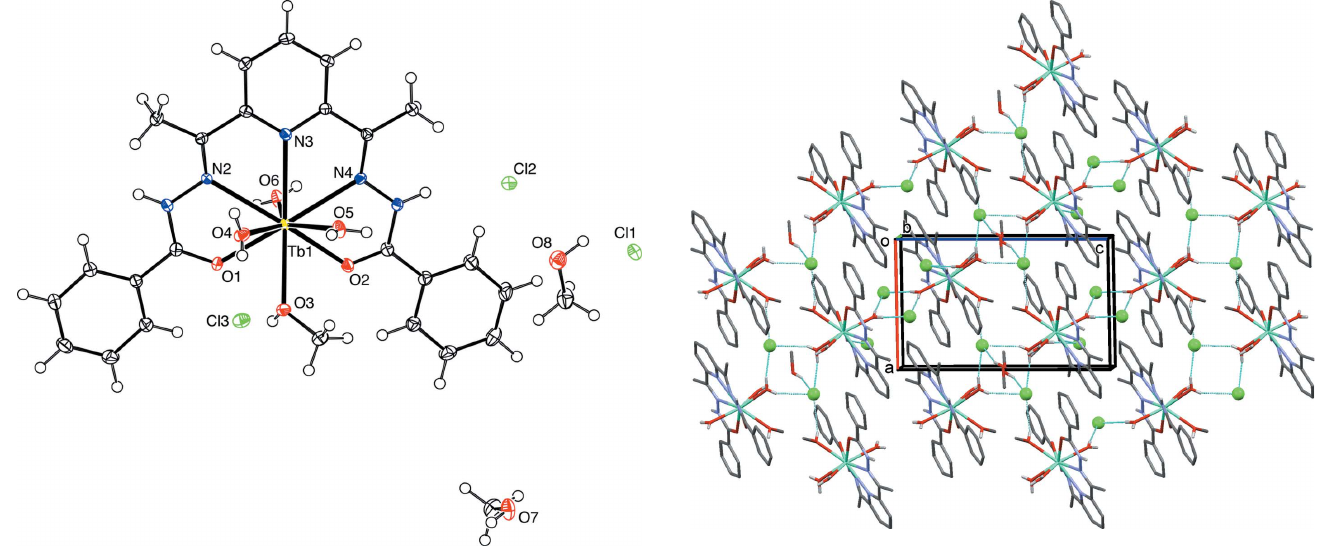
Figure 1 Molecular structure of the Tb III complex, showing the selected atom- labelling scheme. Displacement ellipsoids are drawn at the 50% probability